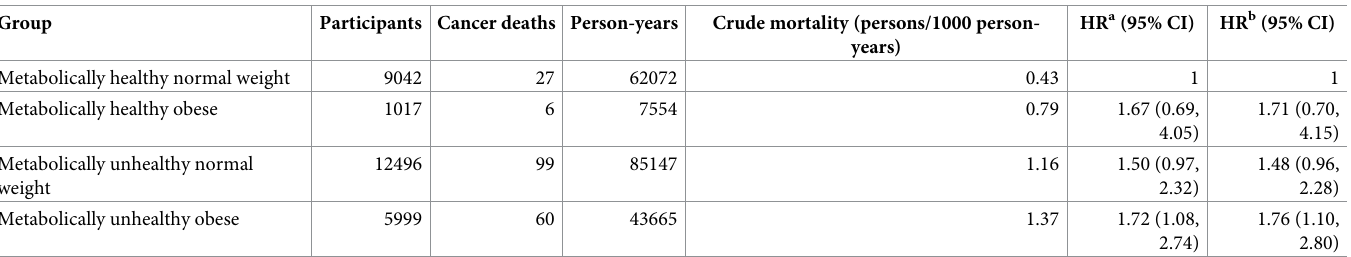
Table 3. Hazard ratios and 95% confidence intervals for total cancer mortality in relation to metabolically healthy status and body mass